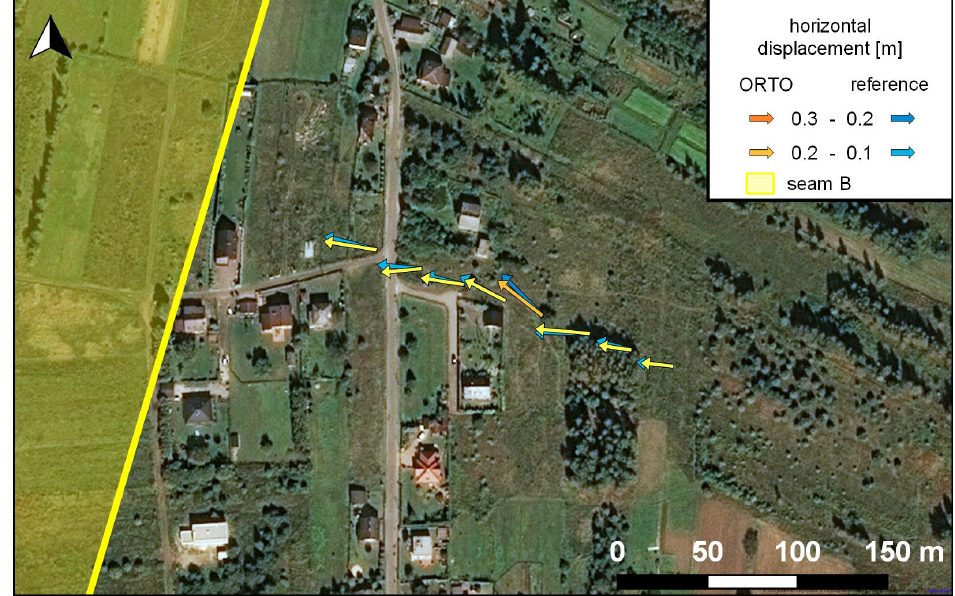
Figure A3. Horizontal displacements determined via the UAV photogrammetric method (ORTO method) and reference measurements at the Jaworzno site.